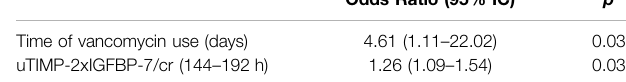
TABLE 8 | Logistic Regression associated with recovery of kidney function.